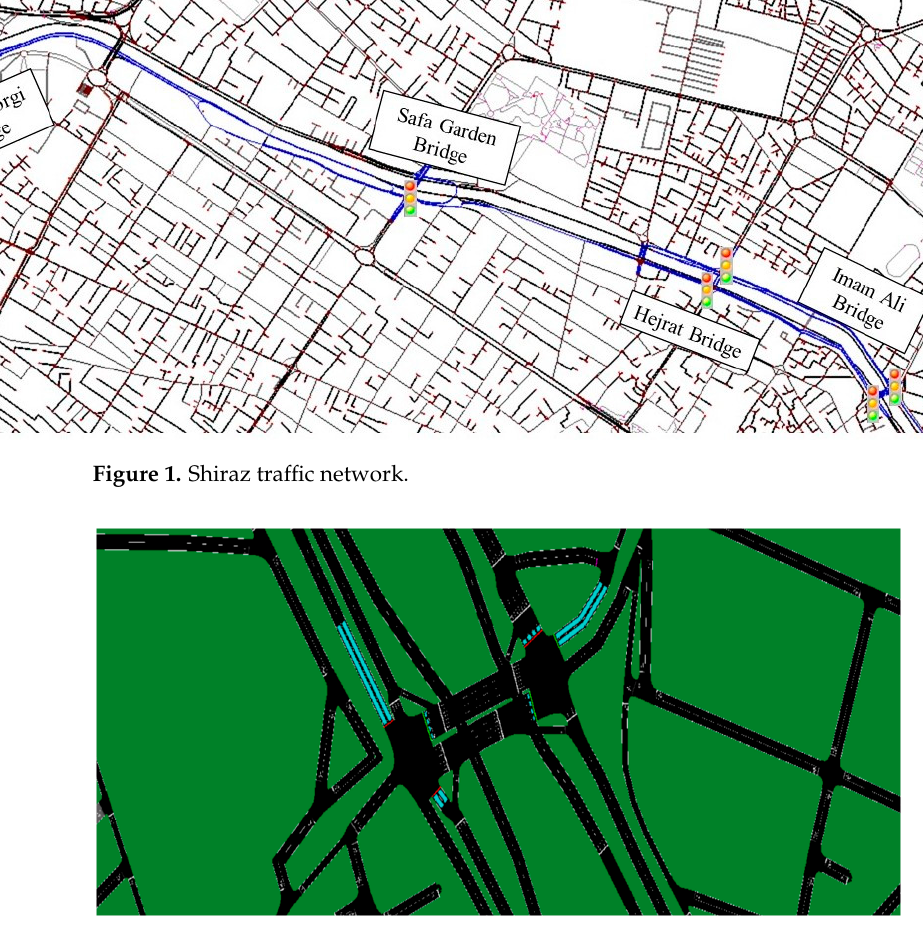
Figure 2. North and south intersections.